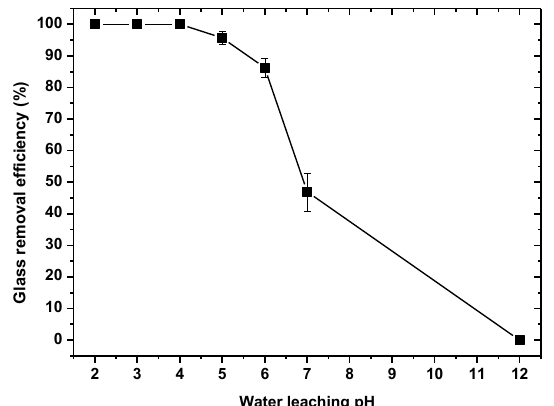
Figure 7. Effect of water leaching pH on glass removal efficiency (experimental conditions: abrasive – glass polishing waste: approximately 1 g; roasting temperature: 450 °C; mass ratio of polishing waste to NaOH: 1:1; roasting time: 30 min; leaching temperature: 25 °C, liquid – solid ratio: 200